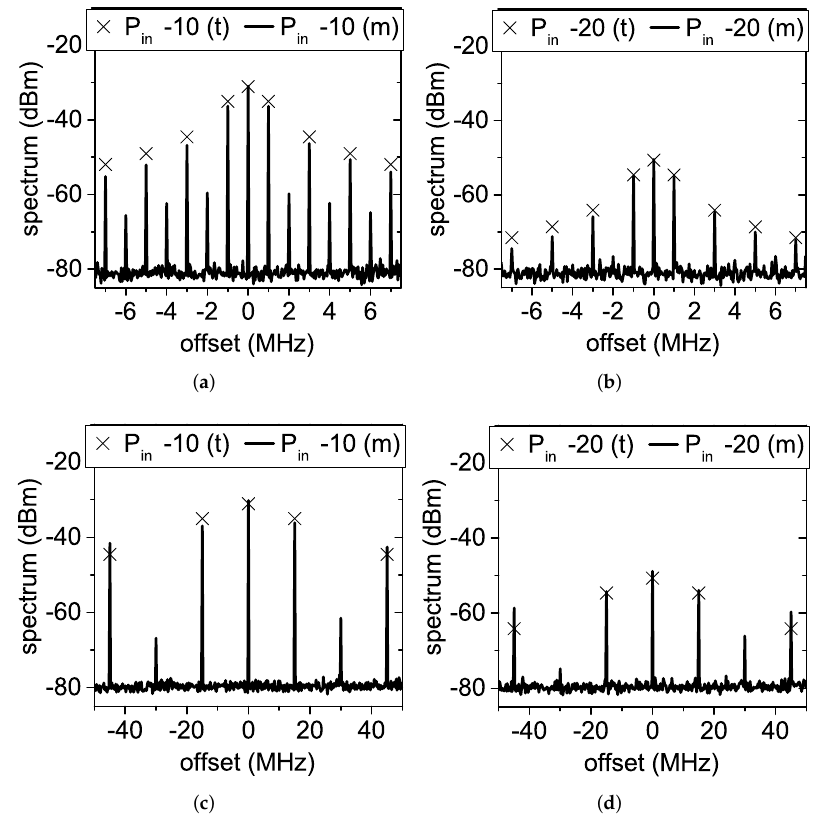
Figure 8. Output spectrum of the modulation-capable frequency doubler: comparison between theory and measurements. ( a , b ) f m = 1 MHz and ( c , d ) f m = 15 MHz. ( a , c ) P in = − 10 dBm and ( b , d ) P in = − 20 dBm. “t” stands for theory and “m” for